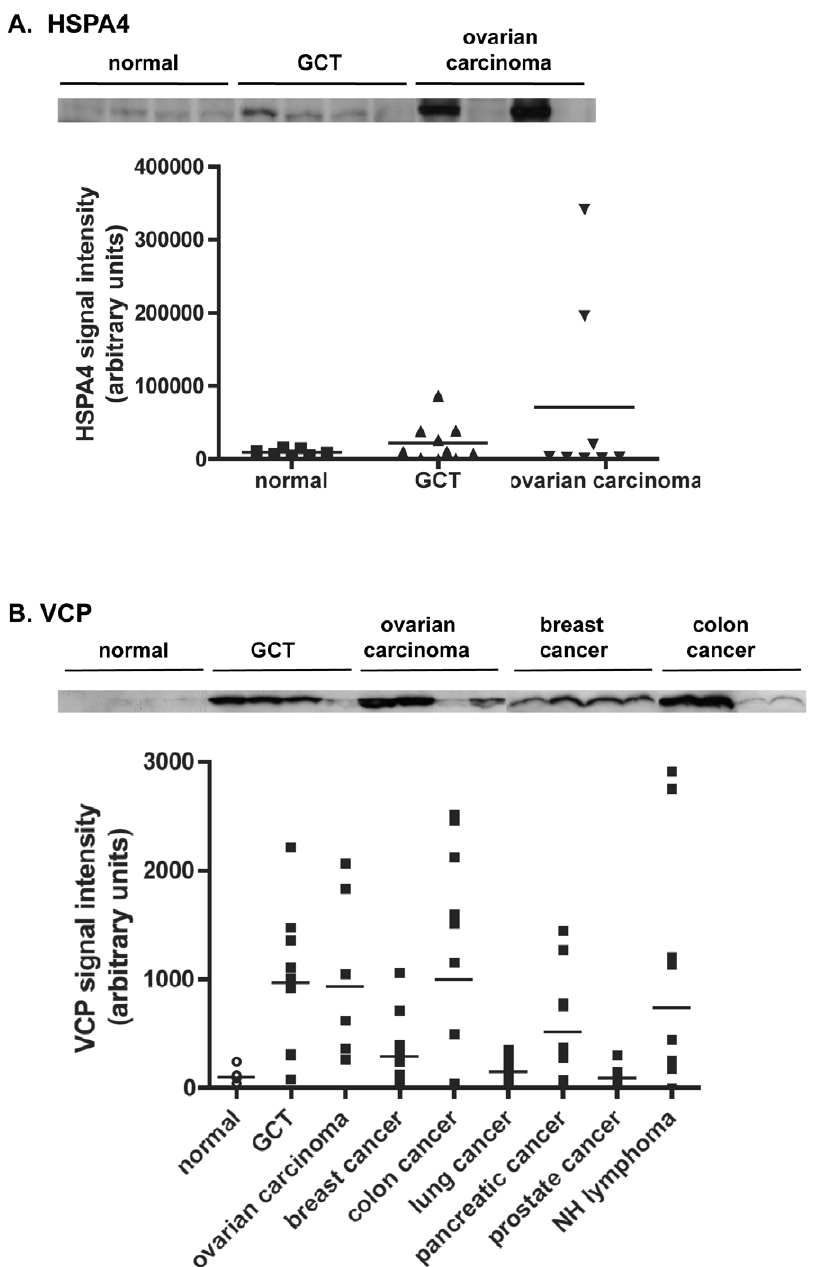
Figure 2. Serum levels of HSPA4 and VCP in healthy volunteers and in cancer patients. (A) HSPA4 levels in the serum of women with GCT or ovarian carcinoma. Equal amounts of serum protein were separated by SDS-PAGE and were subjected to immunoblot analysis for HSPA4 levels (representative blots are shown in the top panel, each lane represents a single donor). Densitometry analyses of signals obtained with the HSPA4 immunoblot analyses are reported in a graph in which each dot represents a single donor (bottom, horizontal bar=mean). No significant difference in HSPA4 levels was detected among groups by one-way ANOVA. (B) VCP levels are increased in the serum of cancer patients. Sera were analyzed as in (A) for the presence of VCP in patients with breast, colon, lung, pancreatic or prostate cancer, ovarian carcinoma, GCT, or non-Hodgkin’s (NH) lymphoma. Statistically significant differences ( P , 0.05) were detected between the control (normal) and GCT and colon cancer groups.